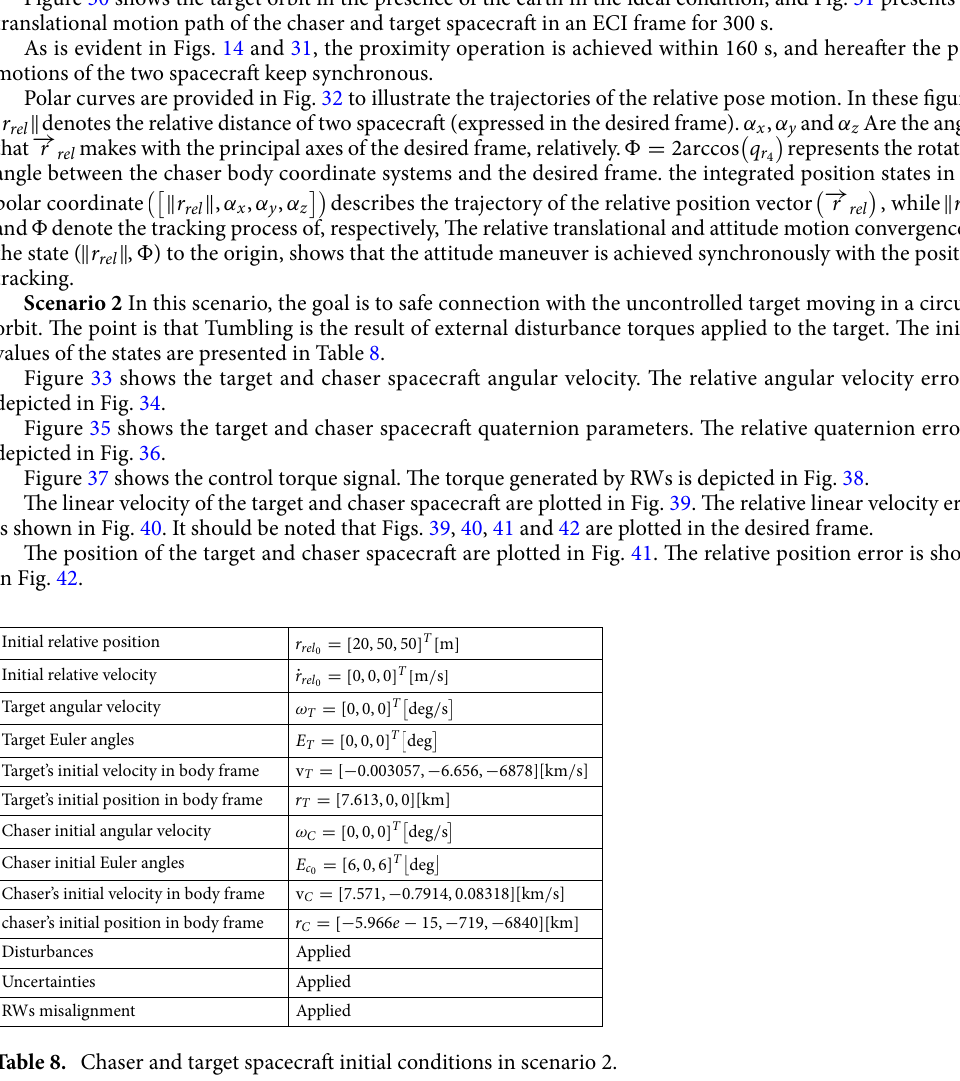
Table 8. Chaser and target spacecraft initial conditions in scenario 2.